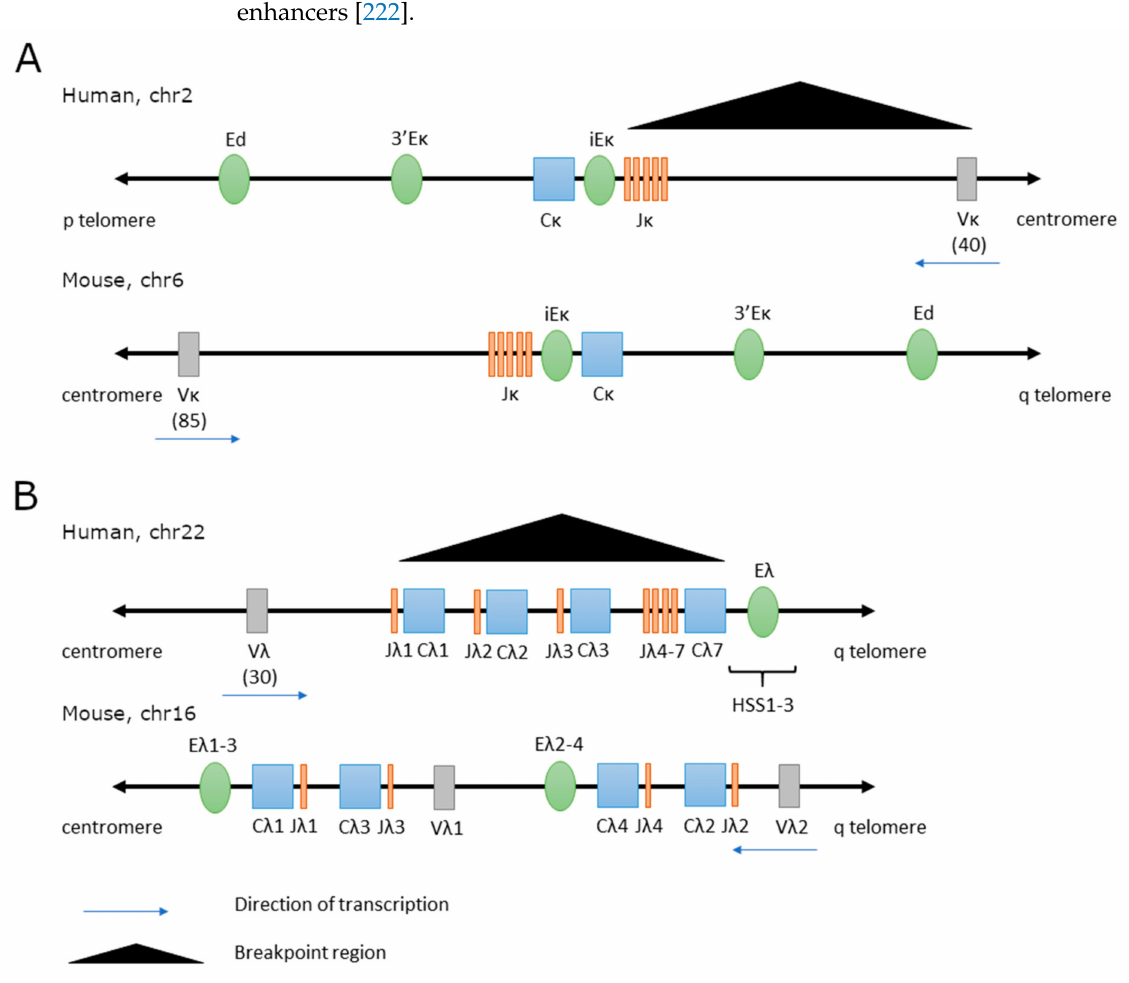
Figure 3. Organization of the human and murine IGK ( A ) and IGL ( B ) loci. Numbers below V κ and V λ indicate the number of variable gene segments. Blue arrows depict the direction of transcription. Black triangles mark regions of breakpoints involved in translocations in malignant